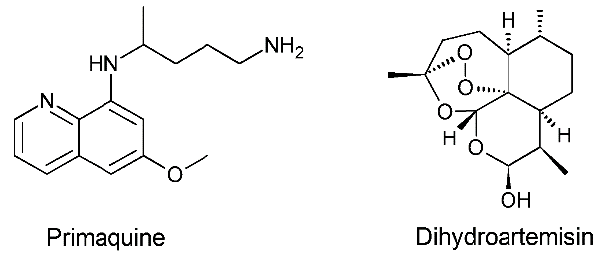
Figure 17. The two antimalarial drugs tested in polyphosphazene